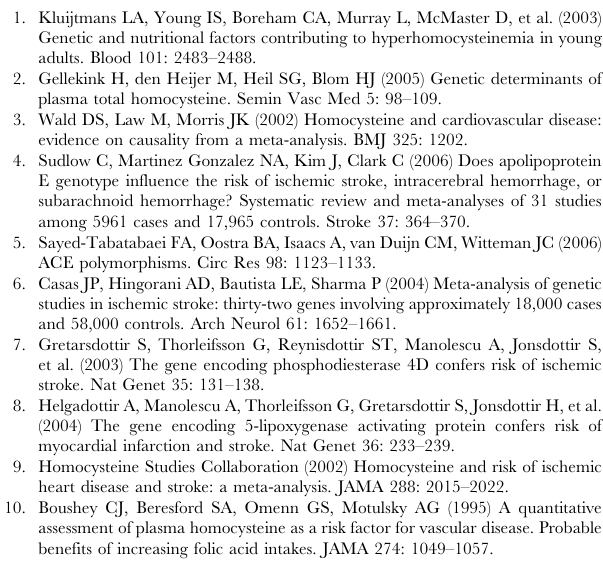
Table S1 Cochran-Armitage Trends Test Result for the 147 Tagging SNPs. Table S2 Number of SNPs Analyzed for each Candidate Gene. Table S3 SNPs selected for replication study. Table S4 Association of 3 Significant SNPs with Ische- mic Stroke Susceptibility under Different Inheritance Models. Table S5 Power Calculation for Two-stage Case-Con- trol Association Study (Stage 1: 360 Cases & 354 Controls; Stage 2: 420 Cases & 420 Controls) at